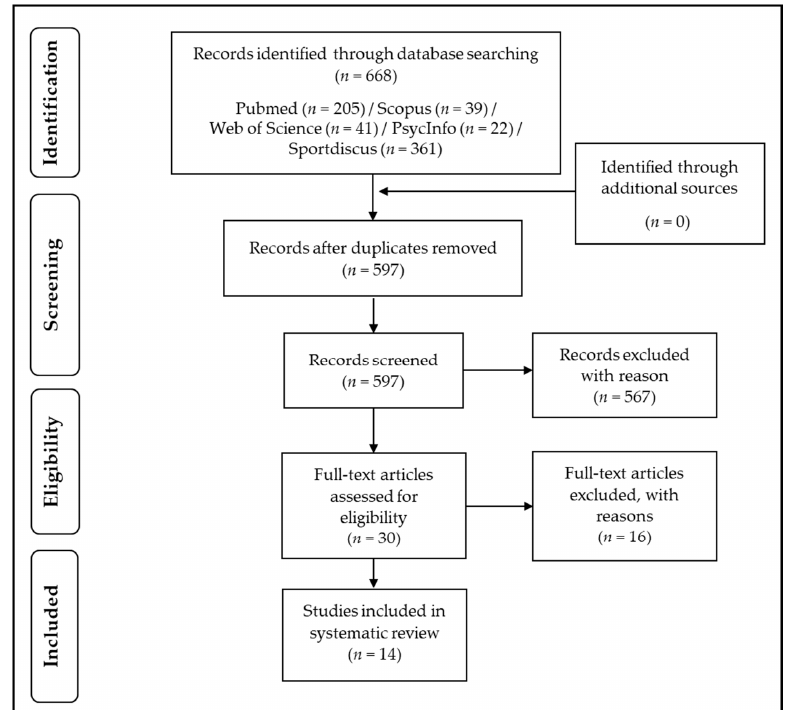
Figure 2. Flow chart with information about the search, screening, and selection processes that led to the identification of the relevant articles for inclusion in this systematic